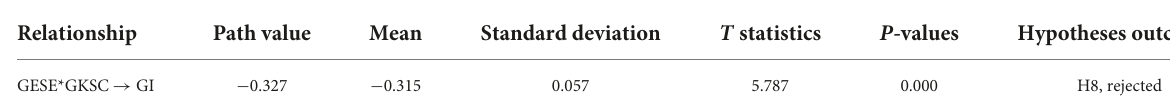
TABLE 7 Moderation relationship.